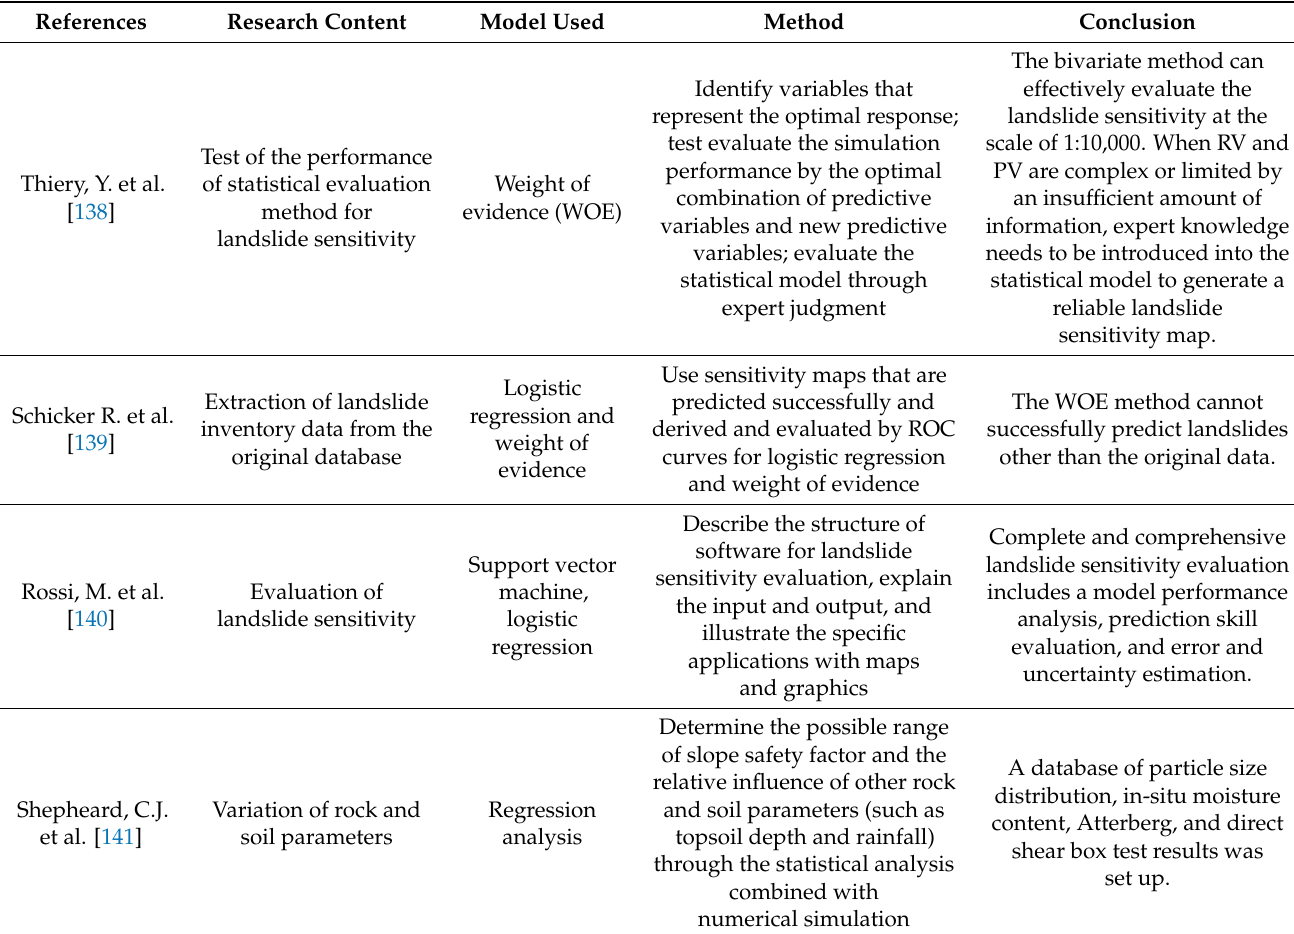
Table 7. Typical cases of statistical models in landslide disaster